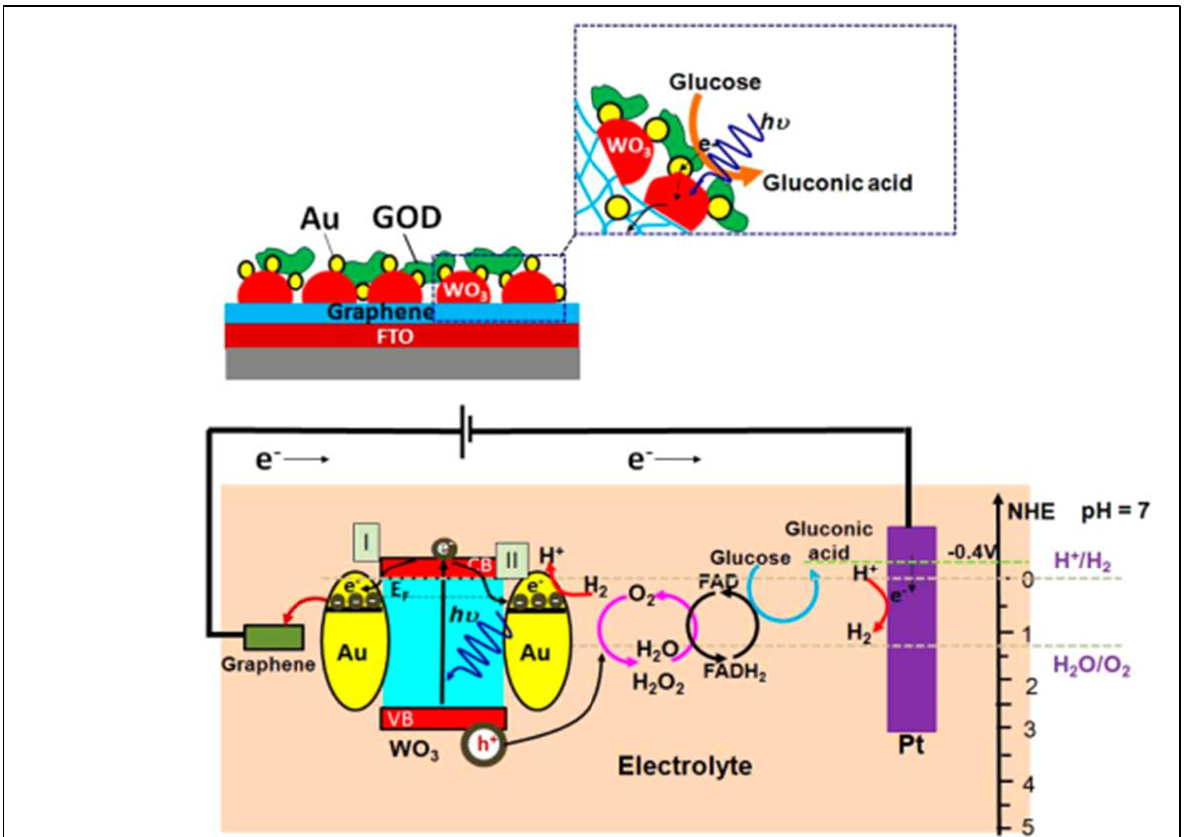
Figure 10. Schematic diagram of Graphene-WO 3 -Au triplet junction and its energy levels. Reprinted with permission from Ref [152]. Electrochimica Acta .